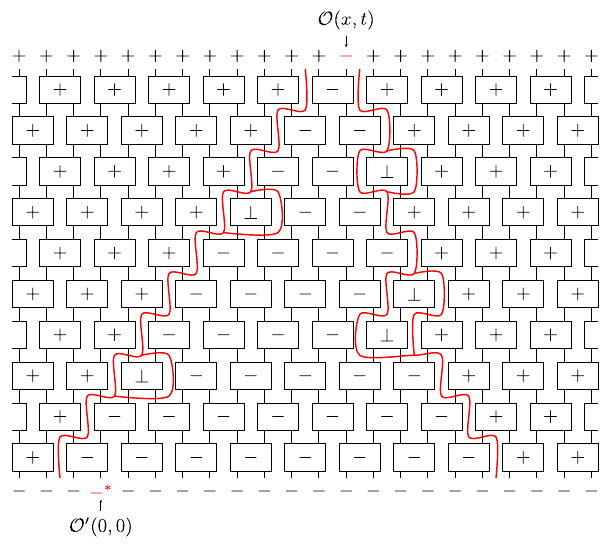
FIG. 14. The membrane picture for the out-of-time-ordered ˜ C ð x; t Þ . The top boundary condition creates two commutator domain walls. The bottom boundary condition favors − , provid- ing an outward force on the lower end points of the two domain walls. The right domain wall thus moves with the optimal speed v . Here, the left wall is forced by the dual state j − (cid:2) i at the B operator insertion point to travel with v > v B